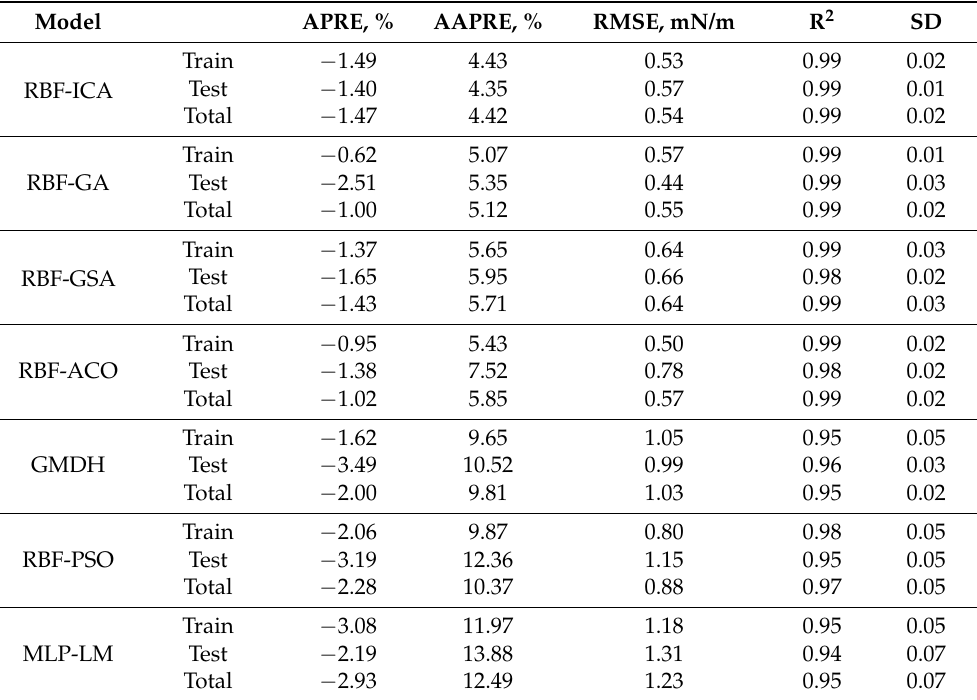
Table 2. Statistical parameters of the proposed models to obtain the IFT values of the CO 2 –n-alkane